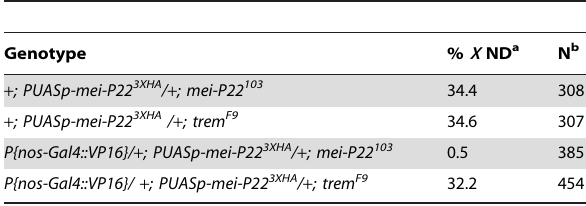
Table 6. Overexpression of Mei-P22 does not rescue the nondisjunction phenotype of the trem F9